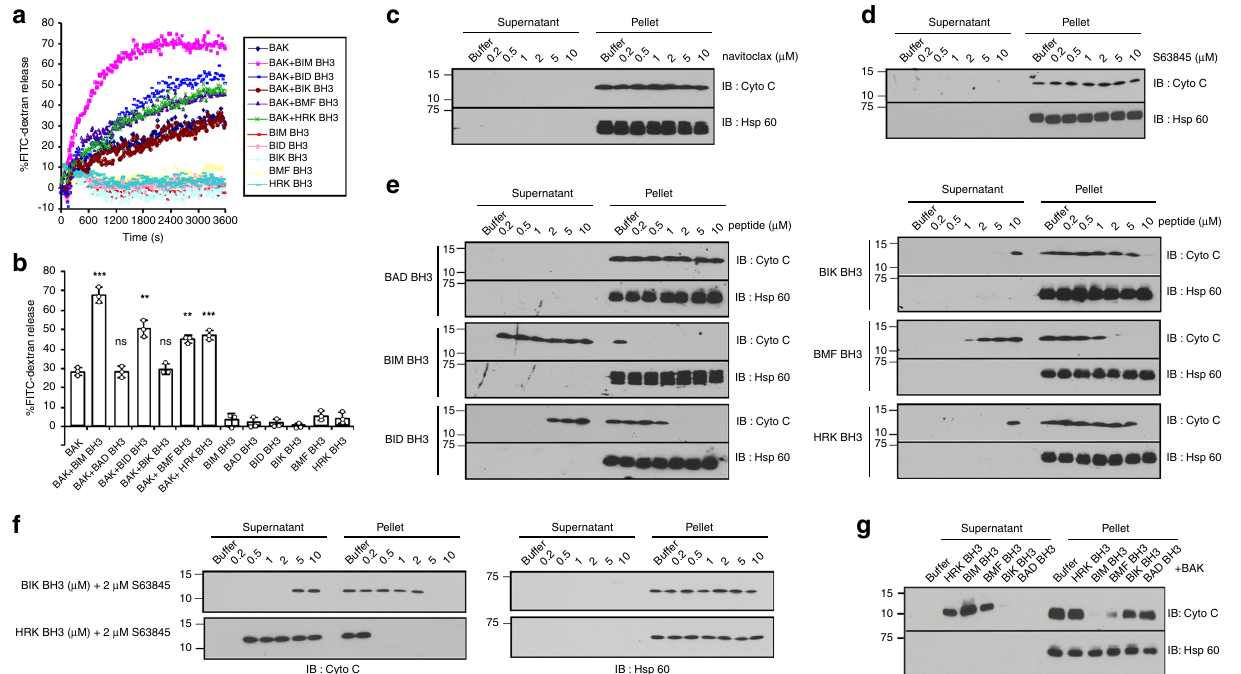
Fig. 2 BMF and HRK BH3 peptides directly activate BAK. a , b Liposome permeabilization assay performed in the presence of 50 nM BAK and/or 50 nM of the indicated BH3 peptides. A representative experiment a and summary of the percentage of FITC-dextran release b are shown. Error bars: mean ± S.D. of three independent experiments. *** p < 0.001; ** p < 0.01; ns, not signi fi cant; two-tailed paired t test, ( p = 0.0008, 0.82, 0.002, 0.39, 0.001, and 0.0004, for BAK + BH3 peptides of BIM, BAD, BID, BIK, BMF, or HRK BH3 peptide vs. BAK alone, respectively). c – f After mitochondria from Bax − / − MEFs were incubated for 90 min at 25 °C with the indicated concentrations of navitoclax c , S63845 d , or multiple BH3 peptides e , or BIK or HRK BH3 peptide plus S63845 f , supernatants and pellets were subjected to SDS-PAGE and immunoblotting. g After mitochondria from Bax − / − Bak − / − MEFs were incubated for 90 min at 25 °C with puri fi ed BAK Δ TM together with the indicated BH3 peptides, supernatants and pellets were subjected to SDS-PAGE and immunoblotting. Numbers on the left side of c – g and western blots in other fi gures indicate migration of the molecular markers. Cyto c, cytochrome c. Source data are provided as a source data fi